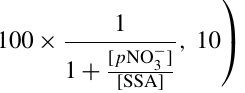
Aircraft 1.2 Lightning 5.8 Total c